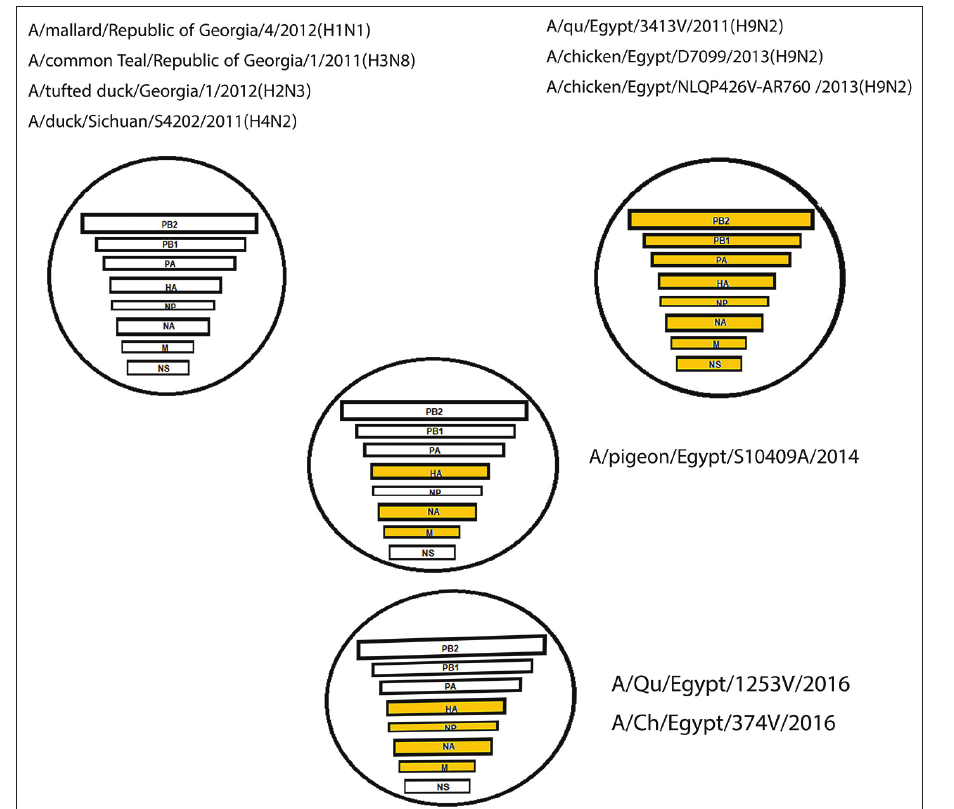
Figure-1: Schematic diagram of the novel reassortant Egyptian H9N2